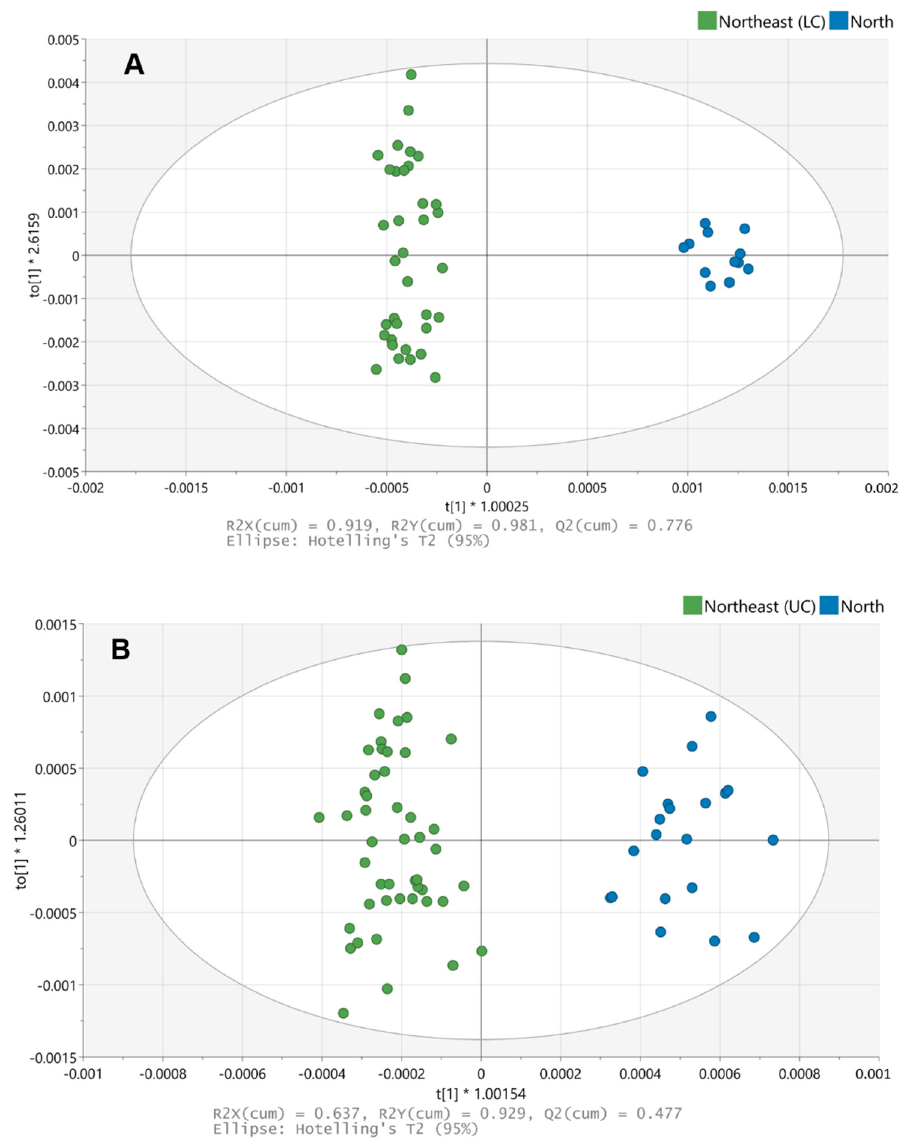
Figure 2. OPLS-DA models of the training dataset analyzed with FTIR-ATR: year 2018 ( A ) and 2019 ( B ). Table 2. Benchtop FTIR-ATR: goodness of fit and predictive ability of OPLS-DA models for the 2018 and 2019 datasets. Year N (Train.